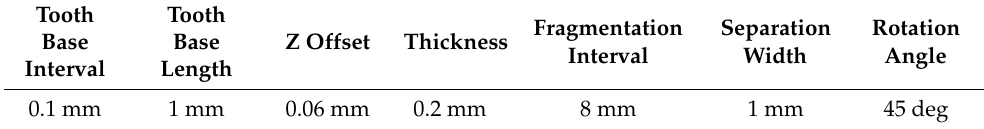
Table 2. Constant parameters.